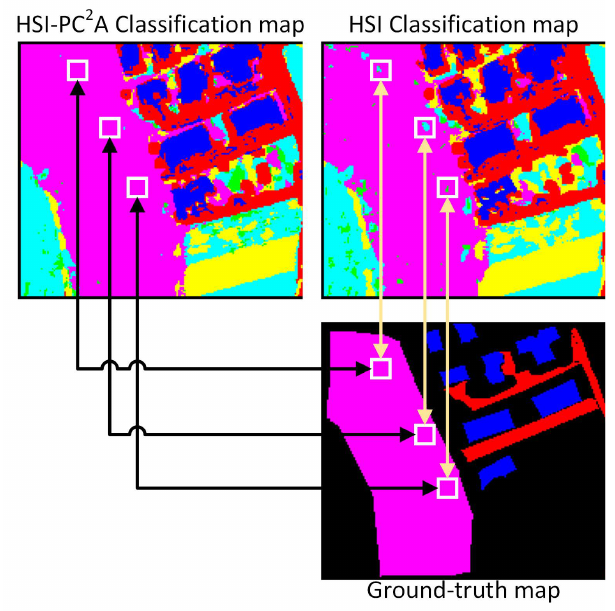
Figure 8. Partial detail classification diagram with/without PC 2 A module on Trento